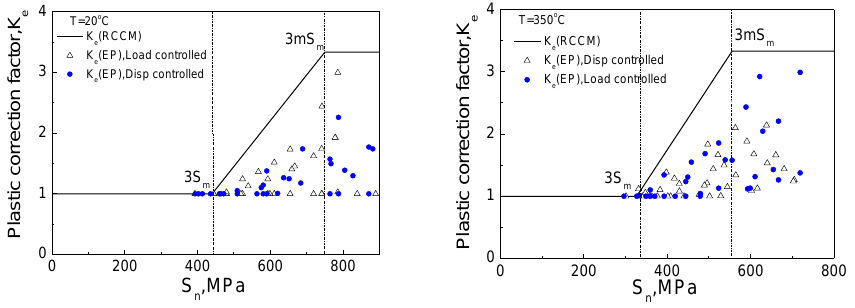
Figure 7. K e with S n under different loading control modes with notched sheet model.